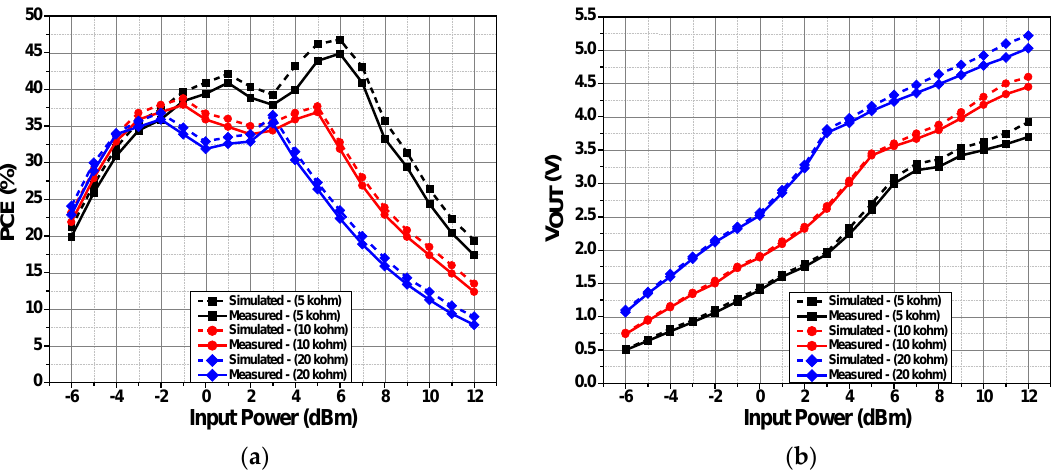
Figure 14. Simulated and measured results of the proposed circuit for different loads. ( a ) PCE; and ( b ) output DC voltage.